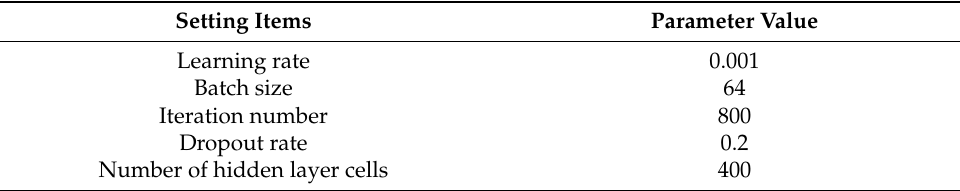
Table 3. Network parameter setting. Setting Items